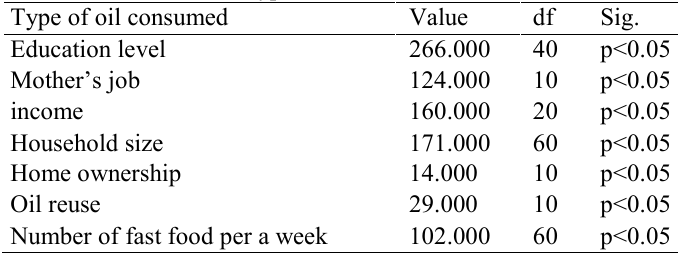
Table 3. Correlations of type of oils and influential factors